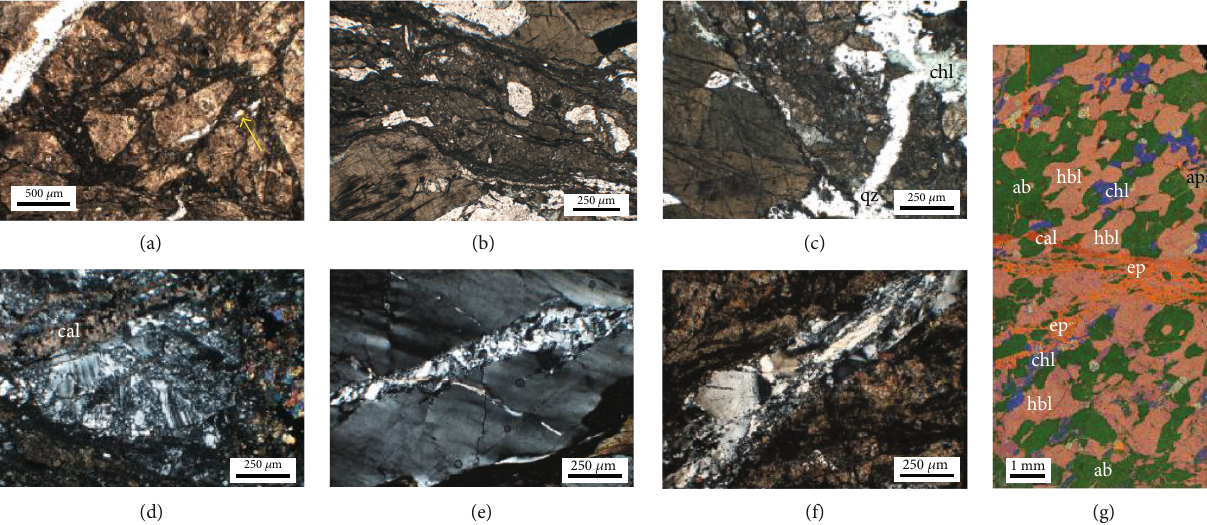
Figure 4: Photomicrographs of fracture systems. (a) Brecciated texture of epidosite cataclasite (thin section I), with mylonitized quartz- fi lled vein (top left) and fragments of mylonitized quartz- fi lled vein (arrowed) within individual clasts of epidosite in a fi ne-grained epidote matrix (PPL); (b) cataclasite composed of clasts of amphibole in an epidote-rich matrix (thin section G) (PPL); (c) cataclasite of amphibole gneiss, cut by quartz- (qz-) and chlorite- (chl-) fi lled vein (thin section H) (PPL); (d) large highly deformed clast containing brecciated quartz and albite within epidote-rich altered cataclasite (thin section H). Calcite-bearing vein (cal) towards the top of the view (crossed polarized light: XPL); (e) thin band of quartz mylonite within large quartz grain in pegmatite. Original quartz shows extensive subgrain development (thin section F) (XPL); (f) mylonite texture in quartz vein that cuts the epidosite pictured in (a) (thin section I) (XPL); (g) X-ray distribution map showing Ca- (orange), Na- (green), and Mg- (blue) part of thin section G, with central epidote-bearing (intense orange) cataclasite containing small relict clasts of albite (green) and amphibole (pink). Calcite veins show as red (thin section